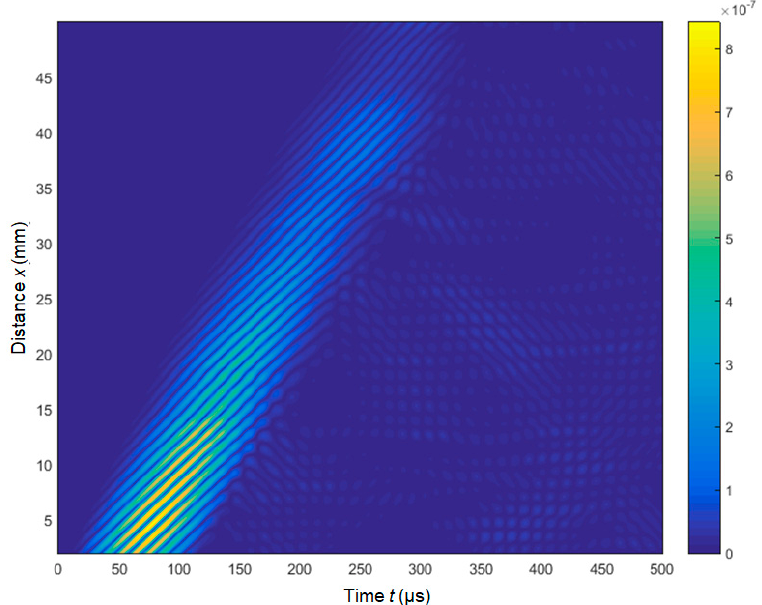
Figure 14. The simulated B-scan of the mica paper sample with multiple circular non-uniformities.